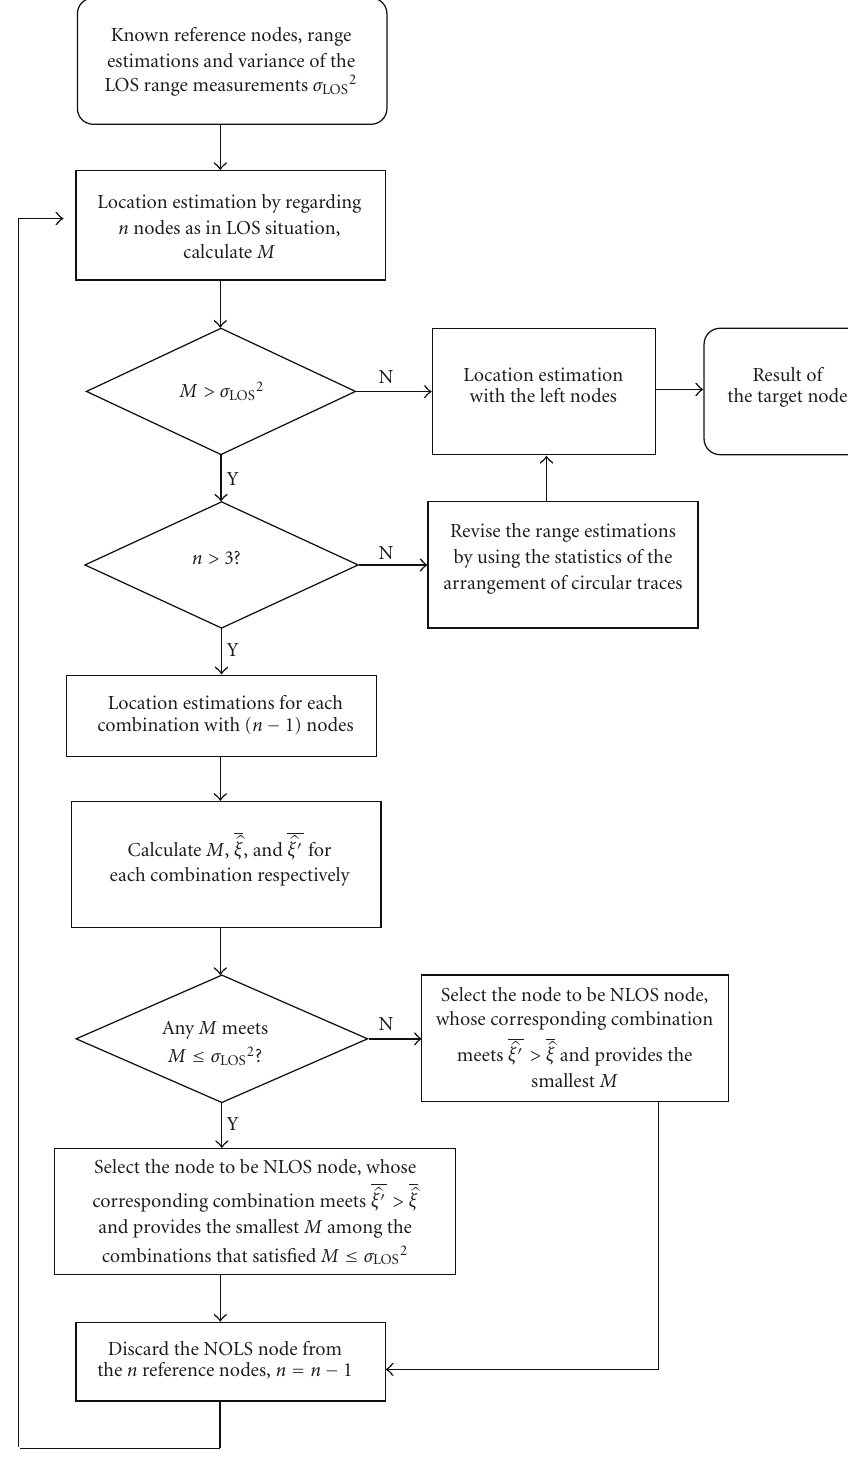
Figure 5: Flowchart of the proposed